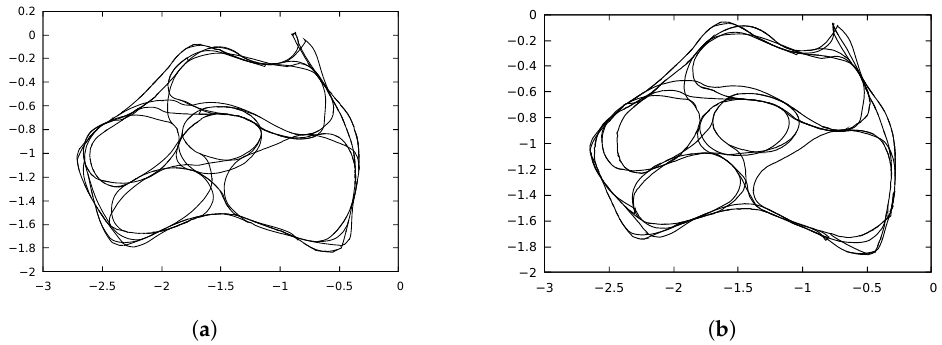
Figure 5. ExperienceMap generated in iRat experiment. ICP error obtained was 0.0117619. ( a ) iRat robot path found by OpenRatSLAM. Time: 960 s. ( b ) iRat robot path found by xRatSLAM. Time: 245 s.